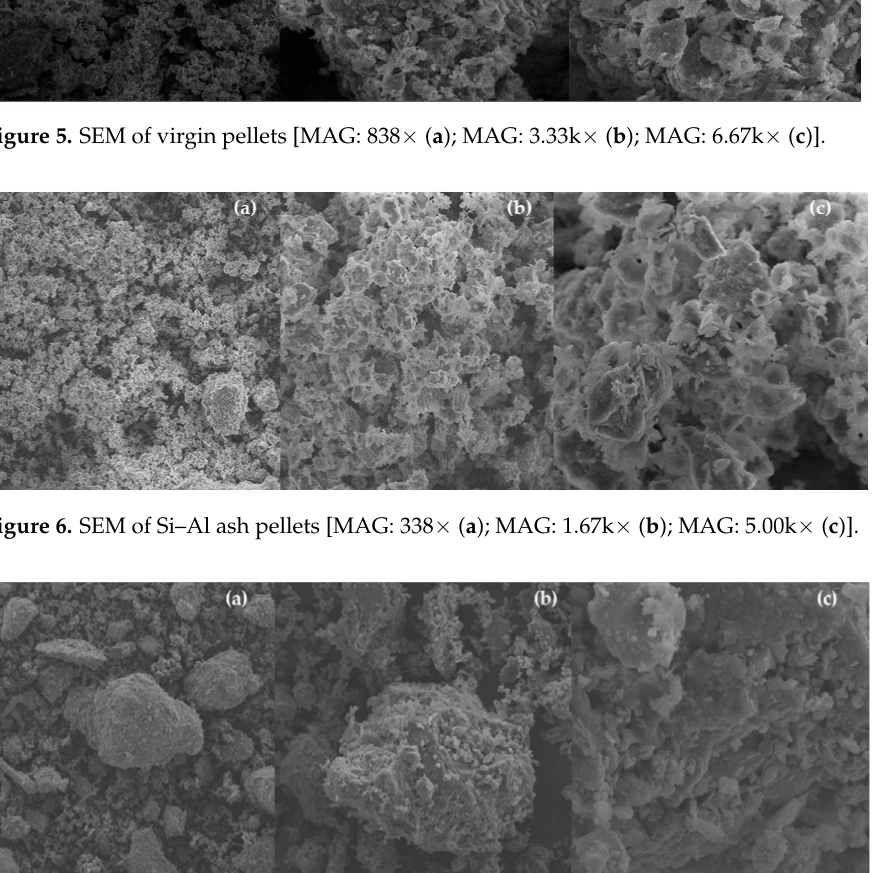
Figure 7. SEM of Si–Al ash pellets after catalytic upgrading of WEEE plastic pyrolysis vapors [MAG: 838× ( a ); MAG: 3.33k× ( b ); MAG: 6.67k× ( c )]. Table 2. Percentages in mass and atomic mass of virgin pellets, Si–Al ash pellets, and pellets after upgrading experiments.